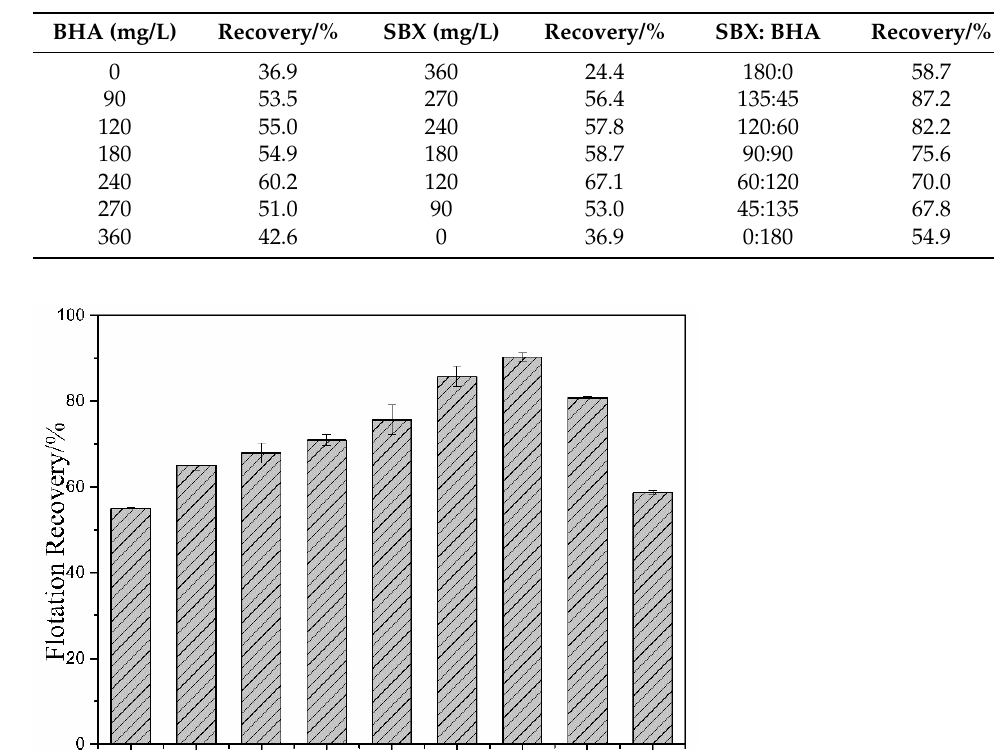
Table 1. The flotation recovery of malachite by using SBX, BHA, and their mixture (the total dosage of SBX + BHA is 180 mg/L).